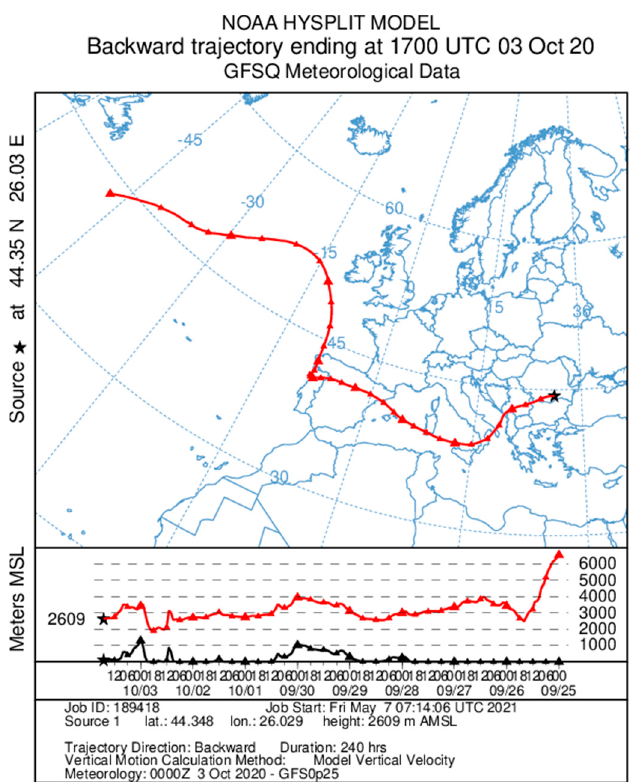
Figure 3. RCS over the last 24 h with overlaps of CBH (upper plot) and ALH (lower plot). The time interval for the last 24 h is shown in the title.